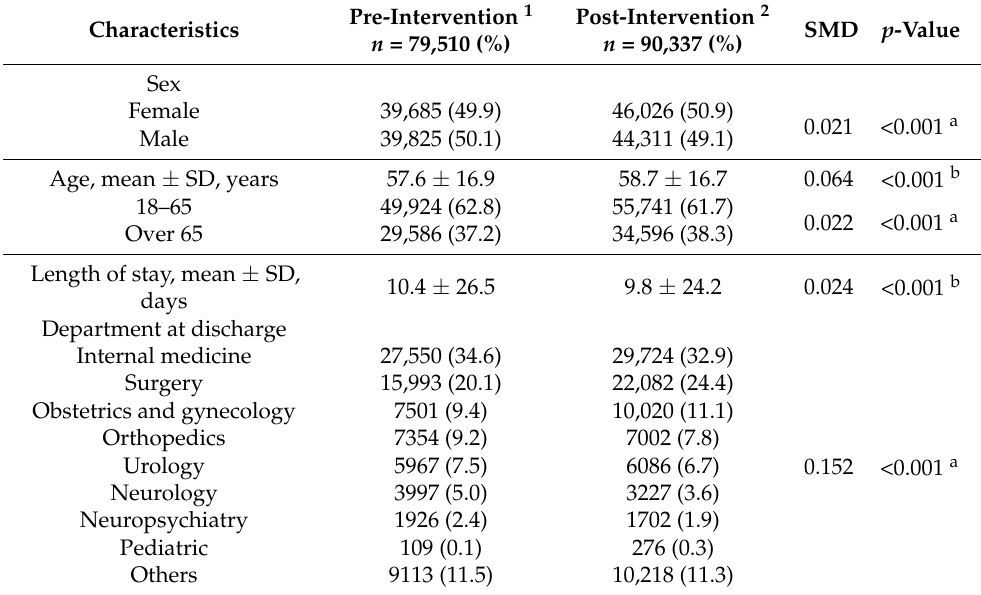
Table 1. Demographics in pre- and post-intervention